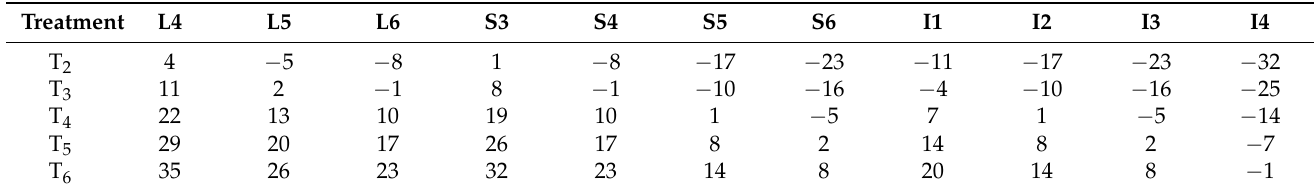
Figure 9. Amplitude in organ length increase relative to W 0 with irrigation at different growth stages of each organ. Table 6. The corresponding relationship between the treatment times and the times of organ entry into the GIP.